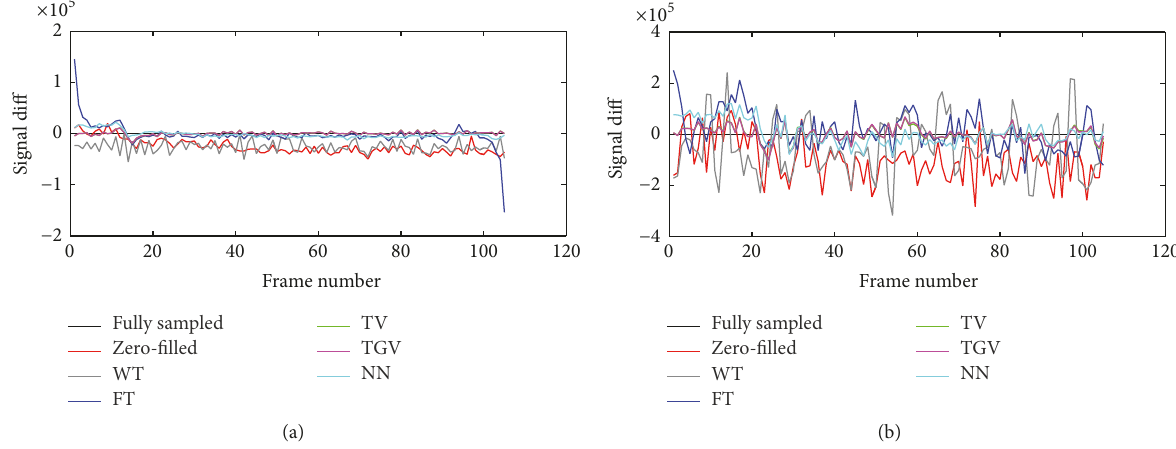
Figure 6: Difference plots of tumor mean intensity curves (a) and voxel intensity curves (b) in tumor area. Here the coordinate of the voxel is (96, 96). Panel (a) shows that the zero-filled reconstruction underestimated the mean intensity after CA injection. WT underestimated the mean intensity over all the dynamics. FT failed to capture the mean intensity curve in the first and last 5 dynamics. TV and TGV 2 𝛼 best fit the mean intensity curve. NN overestimated the intensity curve before the CA injection and slightly underestimated the intensity curve after the CA injection. Panel (b) shows that zero-filled reconstruction underestimated the voxel intensity after the CA injection. FT and WT oscillated with large amplitude, showing an inaccurate approximation. Both TV and TGV 2 𝛼 reconstructions fluctuated less. NN overestimated the signal in the preinjection period.